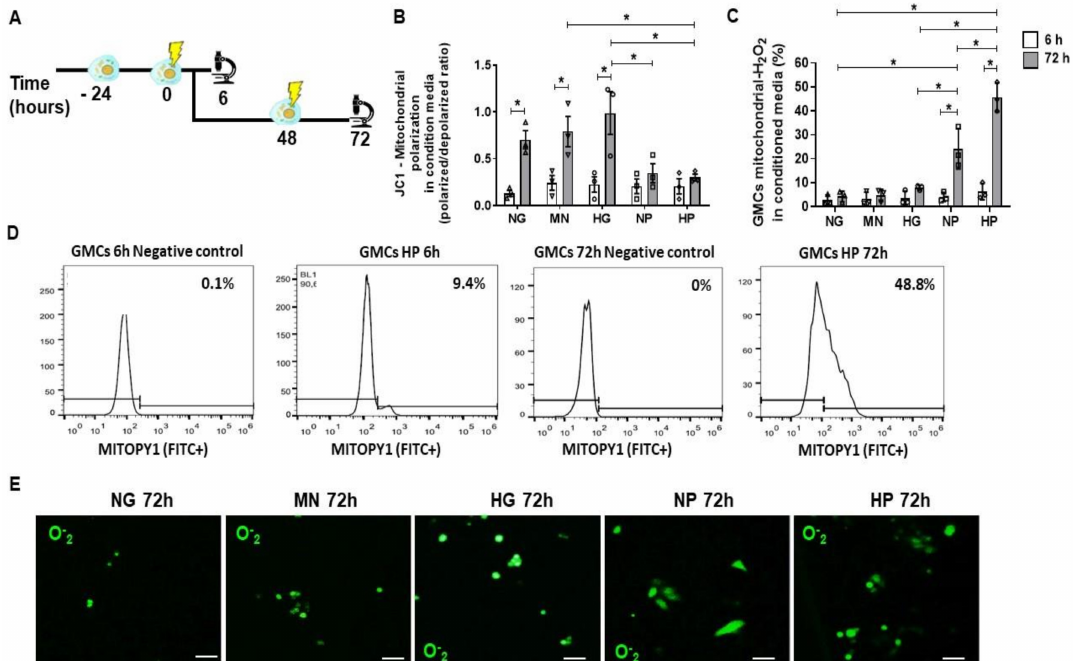
Figure 2. Oxidative stress in GMCs at mitochondrial level after stress-conditioning. ( A ) Scheme of the cellular experiments for GMC conditioning with stress-conditioning media at different time-points (6 h and 72 h). ( B ) Flow cytometry analysis for mitochondria polarization ratio in stress-conditioned glomerular mesangial cells (GMCs) after different time points (6 h and 72 h; polarized/depolarized ratio). Hyper glucose (HG) caused hyperpolarization of GMCs mitochondria in comparison with normal glucose (NP) and hyper glucose + hydrogen peroxide (HP) conditioning, which caused a depolarization in comparison to control media (* p < 0.05). ( C ) Flow cytometry analysis of hydrogen peroxide (H 2 O 2 ) accumulated specifically into GMC-mitochondria (FITC + ) after stress-conditioning media. NP and HP 72 h-conditioning caused expressive H 2 O 2 accumulation in GMCs mitochondria (* p < 0.05). Groups were compared with each other intra and inter each time-point (6 h and 72 h). ( D ) Flow cytometry gating and negative control for mitochondrial-H 2 O 2 accumulation in GMCs conditioned for 6 and 72 h in HP medium. ( E ) Superoxide (O 2 − ) accumulation in GMCs after 72 h in stress-conditioning media in NP and HP, as demonstrated by confocal microscopy (FITC + ). Scale bars represent 200 µ m. Specific accumulation of H 2 O 2 in mitochondria (FITC + ), mitochondria polarization ratio (polarized-RFP+/depolarized-FITC + ) and superoxide anion cell-accumulation (FITC + ) in GMCs conditioned to stress media (normal glucose—NG, mannitol—MN, hyper glucose—HG, normal glucose + hydrogen peroxide—NP, hyper glucose + hydrogen peroxide—HP) during 6 h and 72 h time-points. Error bars represent mean ± SEM; n = 3. * p <